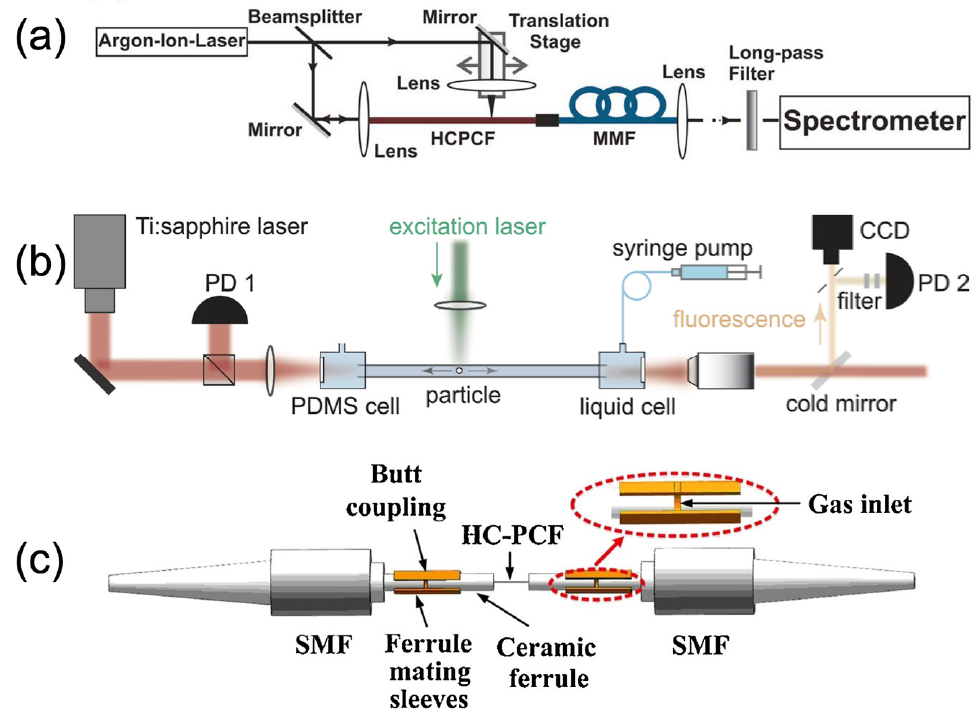
Figure 4. Detection instrument schematics for fluorescent detection. ( a ) A system that uses both end ‐ on and perpendicular excitation to quantify the effects of reabsorption and fiber properties on sensor performance, adapted with permission from [152]. ( b ) A system using a single fluorescent bead with perpendicular excitation and fluorescence emission guiding to determine radiation strength with high spatial resolution, adapted with permission from [138]. ( c ) A system designed for the continu ‐ ous flow of gas through the hollow core for real ‐ time sensing. Excitation and emission are both parallel to the fiber, adapted with permission from [145].